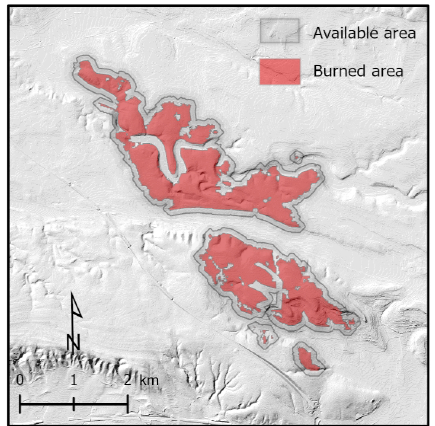
Figure 6. Illustration of the burned area ( r ) and available area ( p ) to be used by a fire. The available area (the sum of the burned area plus buffer zone) around each fire corresponds to twice the burned